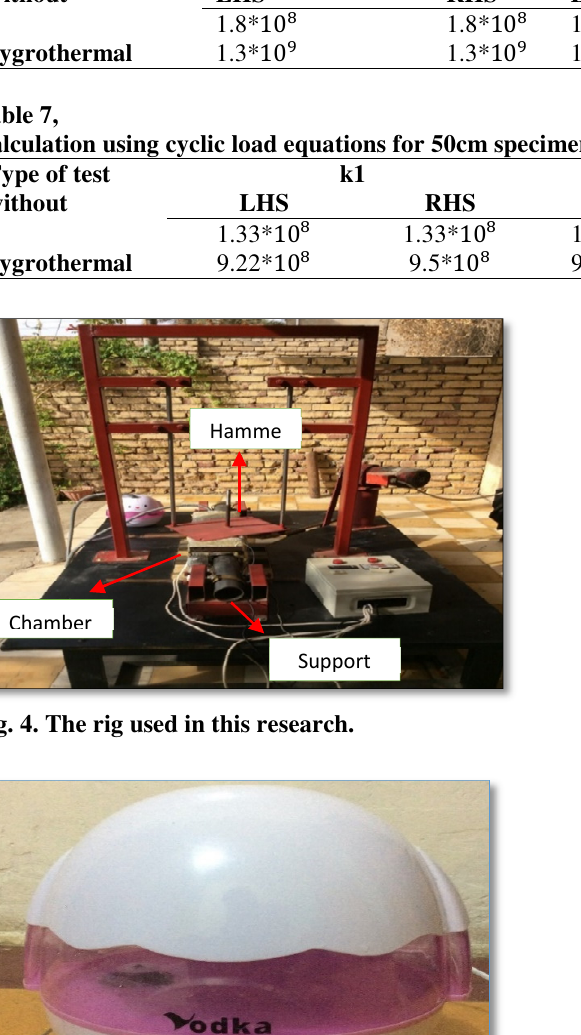
Calculation using cyclic load equations for 100cm specimens Type of test